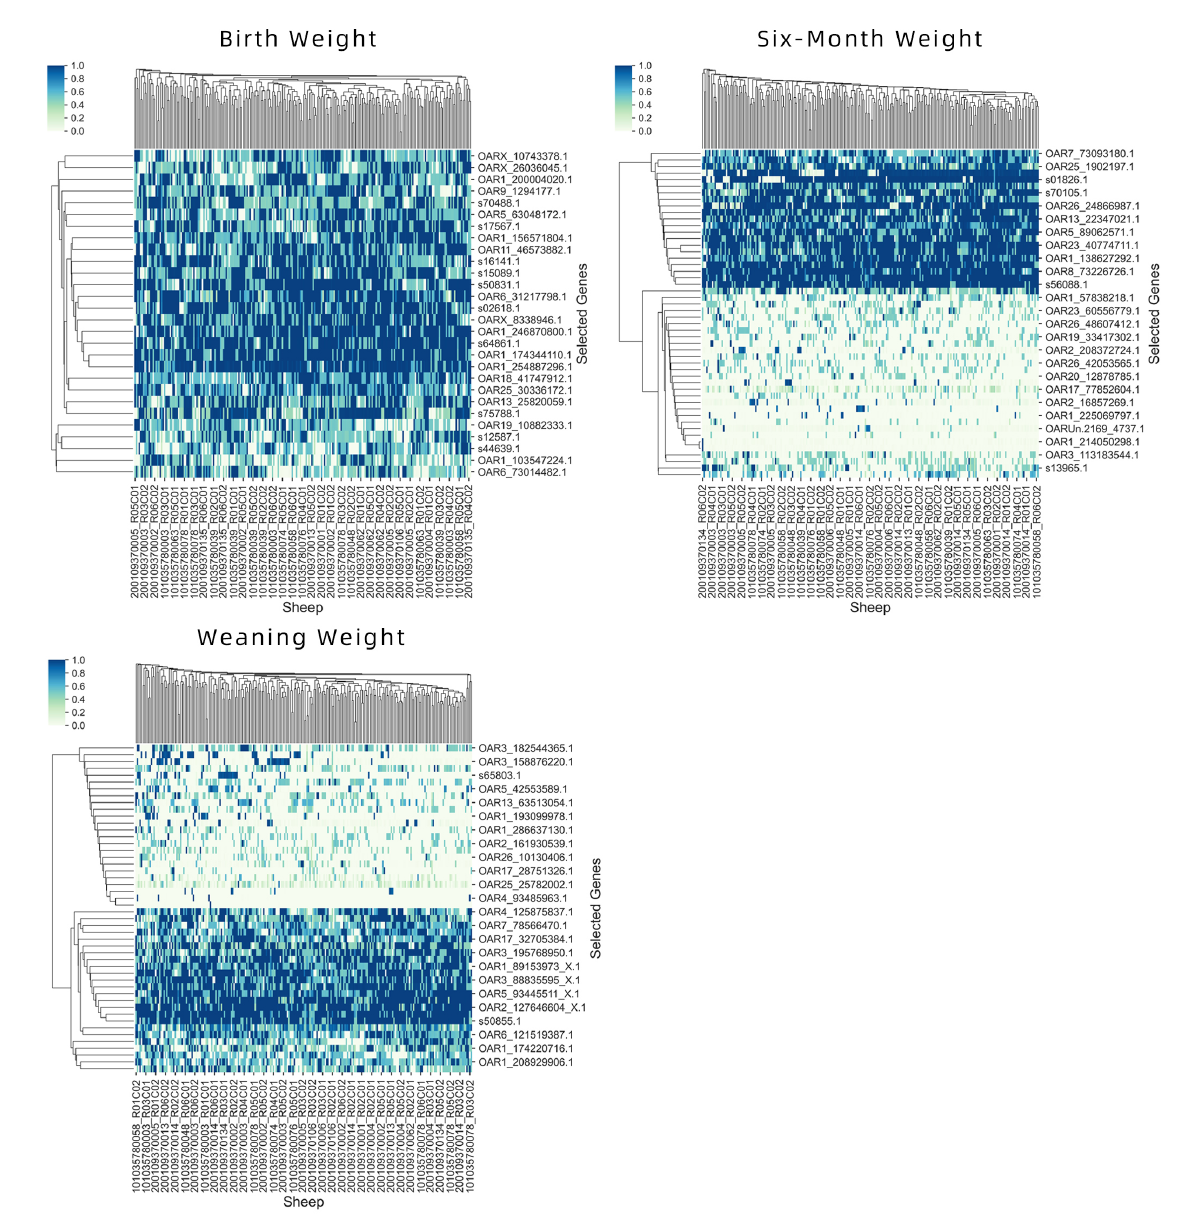
Figure 6. The heatmap of the actual expression profiles for the best subset of genes obtained from the proposed